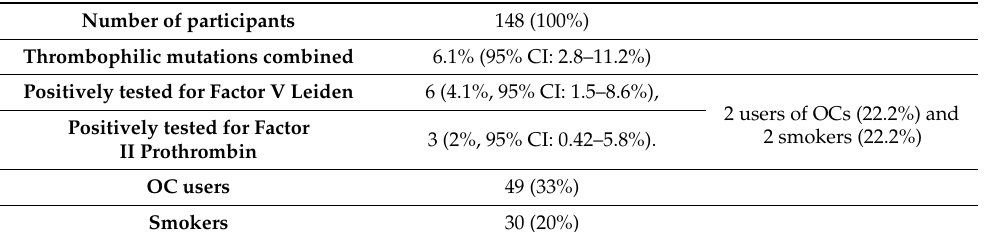
Table 1. Presence of risk factors in the participants in the study. Number of participants Thrombophilic mutations